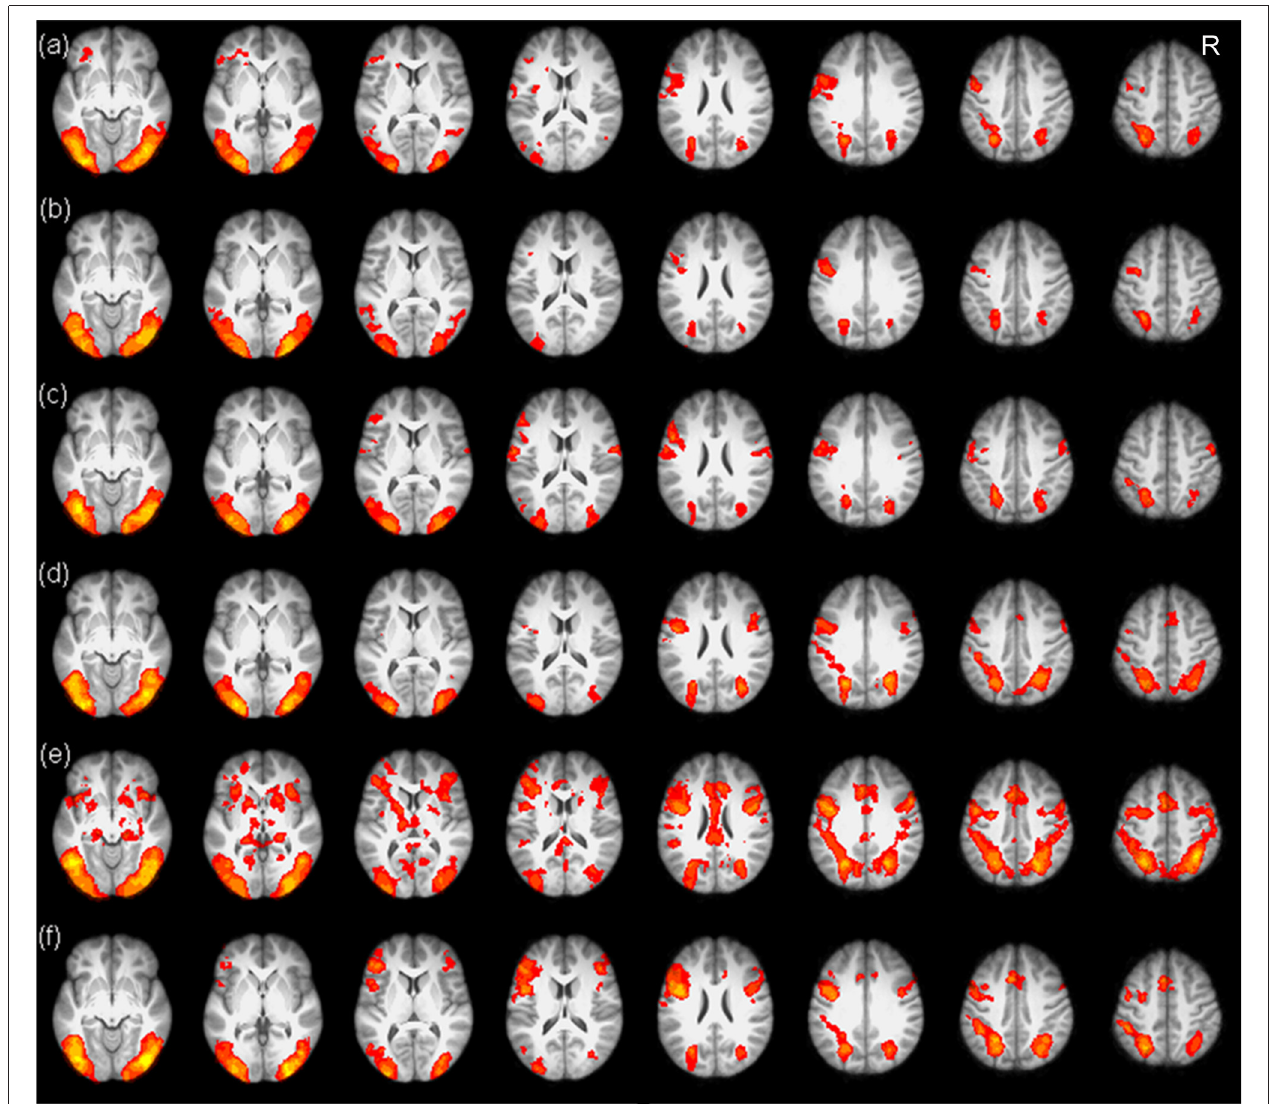
FIGURE 3 | Brain maps of Chinese and artificial language word processing in the three scans. The upper three panels show brain activations for Chinese word processing before training (A) , after 4-day training (B) and after 12-day training (C) . The lower three panels show brain activations for artificial language word processing before training (D) , after 4-day training (E) and after 12-day training (F) . R, right.